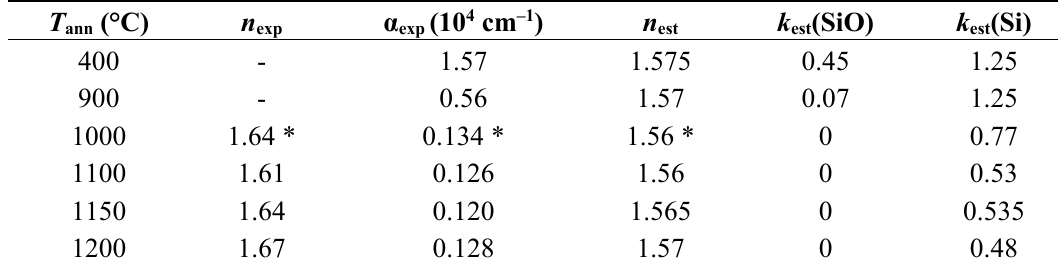
Table 1. Experimental refractive index n exp and absorption coefficient α exp of a SiO 1.75 film for different annealing temperatures T ann and the estimates for the refractive index n est and extinction coefficient k est from the effective medium approximation. Reproduced